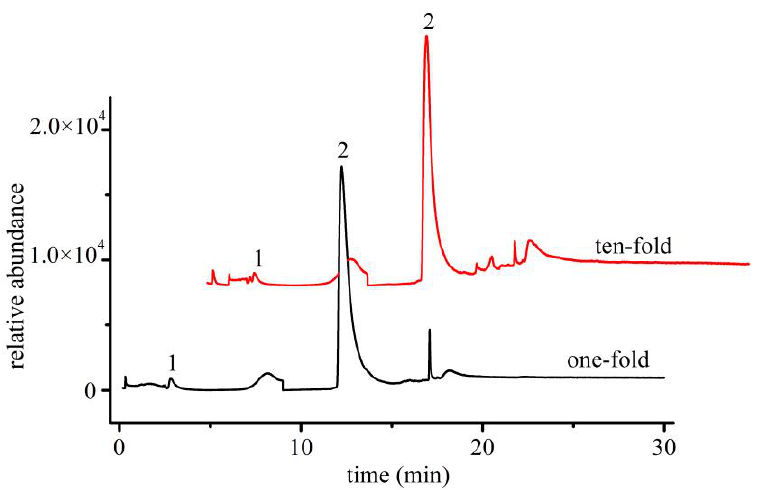
Figure 9. One- and ten-fold interference of PC and PET in PA66 and PA6 standard solutions (1: cyclopentanone; 2: caprolactam).